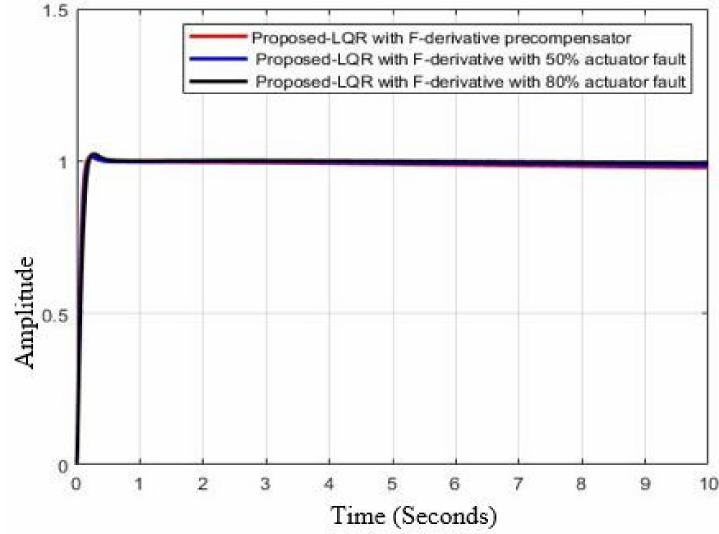
Figure 6. Pitch angle step response with and without